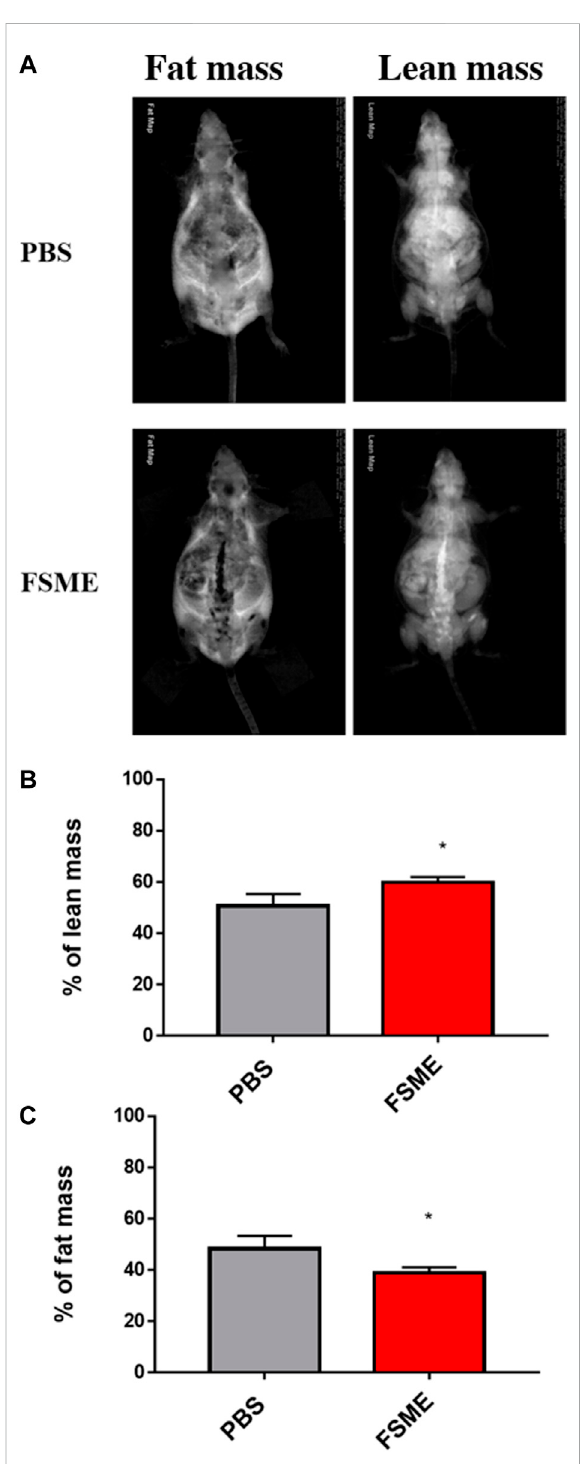
FIGURE 4 FSME group reduced fat mass and increased body lean mass in20-month-oldmice. (A) RepresentativeDXAscanimagesofPBS orFSMEmice.Theleftimagesarefatmassandtherightimagesare lean mass. (B,C) Reduction in percentage of fat mass and increased in percentage of lean mass. * represents p < 0.05 by the Mann – Whitney test. N = 5; results are presented as mean ±